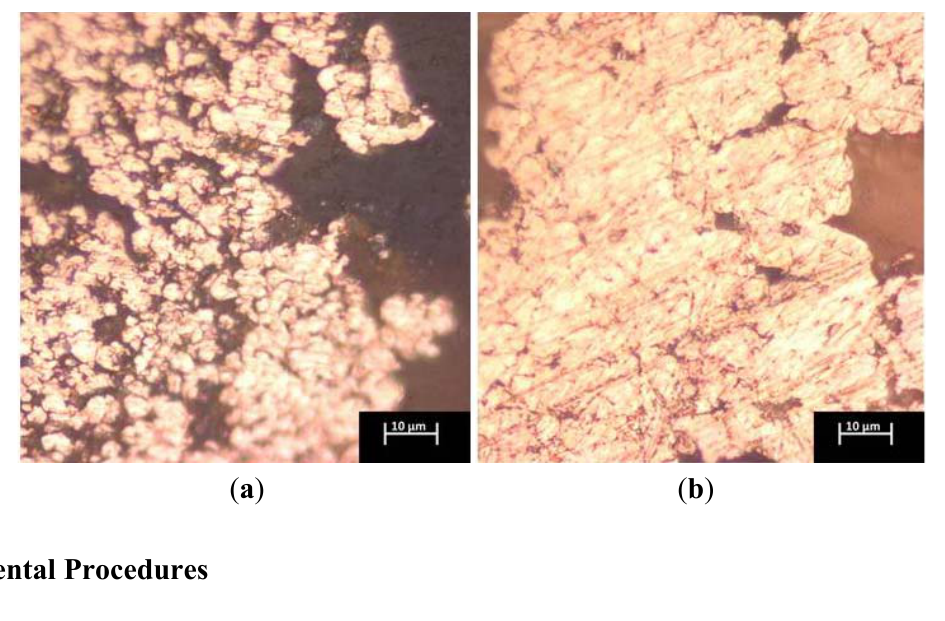
Figure 3. Optical micrographs of longitudinal cross-sections of Cu foams ( a ) as